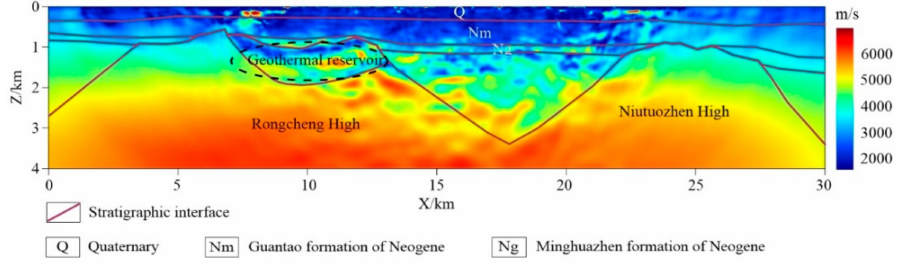
Figure 16. The velocity model and geological structures of Xiong’an New Area [31]. The black circle represents the inferred potential geothermal